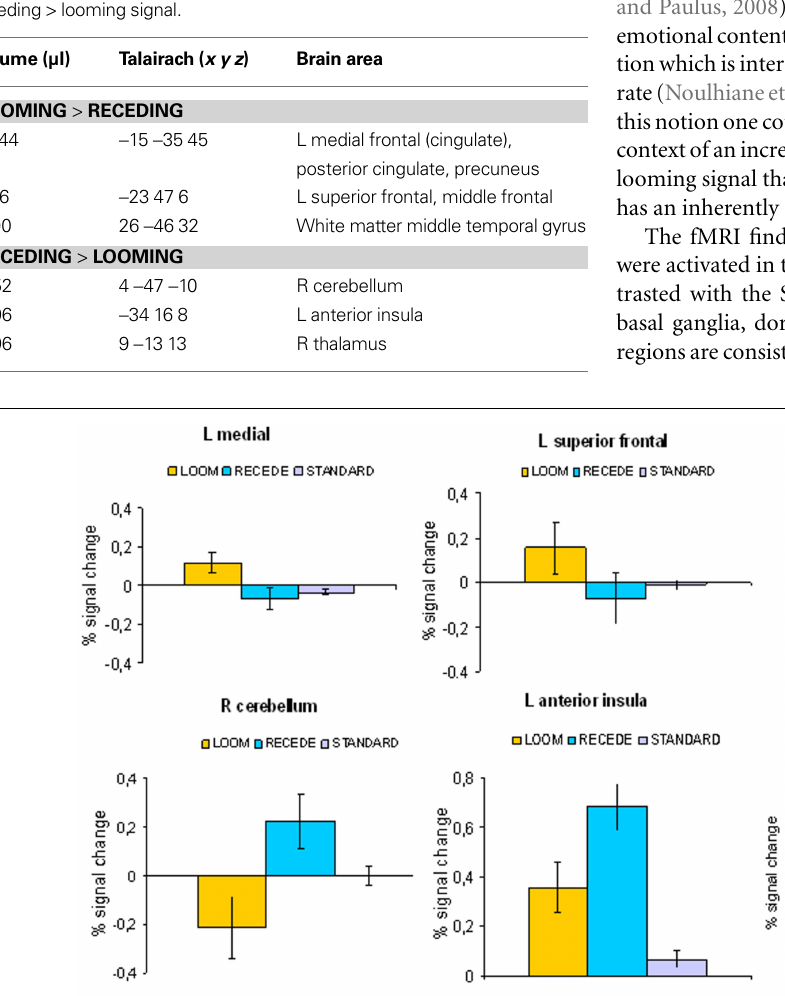
FIGURE 5 | fMRI: LOOM > RECEDE. Percent signal change (mean; SEM) in brain regions with signifi cantly greater activation for the LOOM > RECEDE contrast (upper row: L medial, L superior frontal) and the RECEDE > LOOM contrast (lower row: R cerebellum, L anterior insula, R thalamus) for the three stimulus conditions (LOOM, RECEDE,